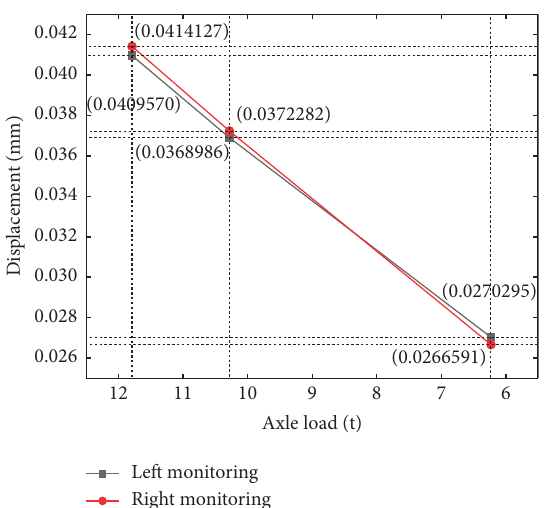
Figure 10: Comparison of maximum vertical displacement of trackbed under different axle loads.